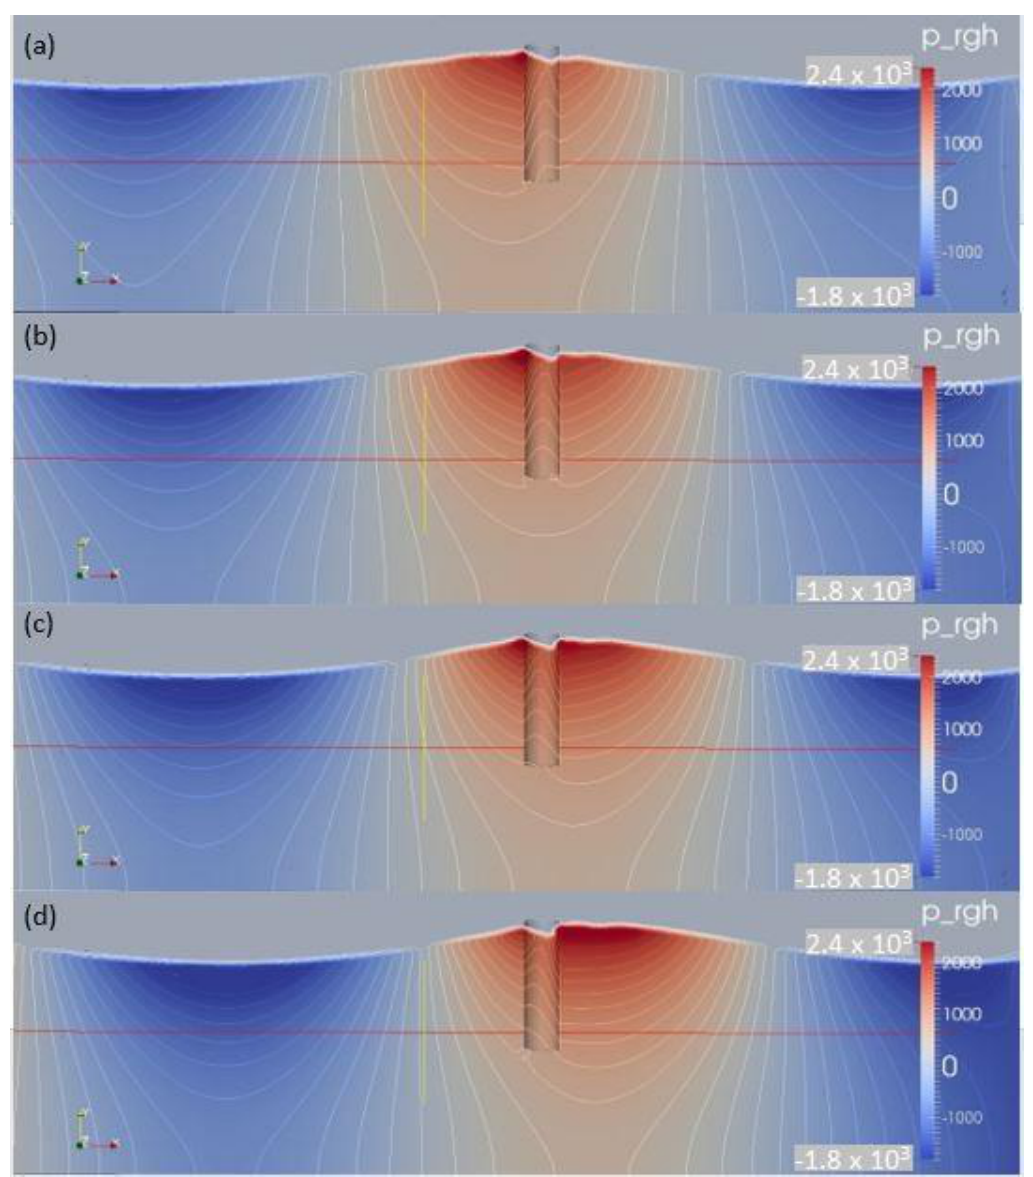
Figure 11. Pressure distribution in the simulation domain from the side, while the cylinder interacts with the incoming wave crest with simulation time for figure ( a ) 0.19Ts, ( b ) 0.0.25Ts, ( c ) 0.31Ts and ( d ) 0.37Ts. The flow field pressure distribution is for case 9, with wave period of T = 2.50 s and wave height of H = 0.46 m.